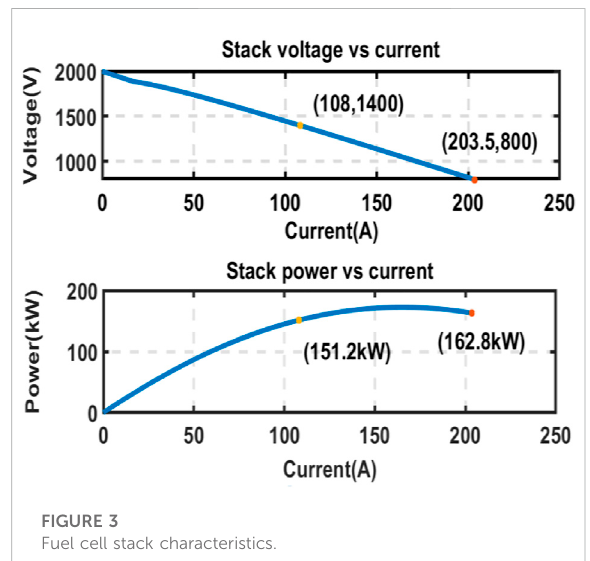
FIGURE 3 Fuel cell stack characteristics.